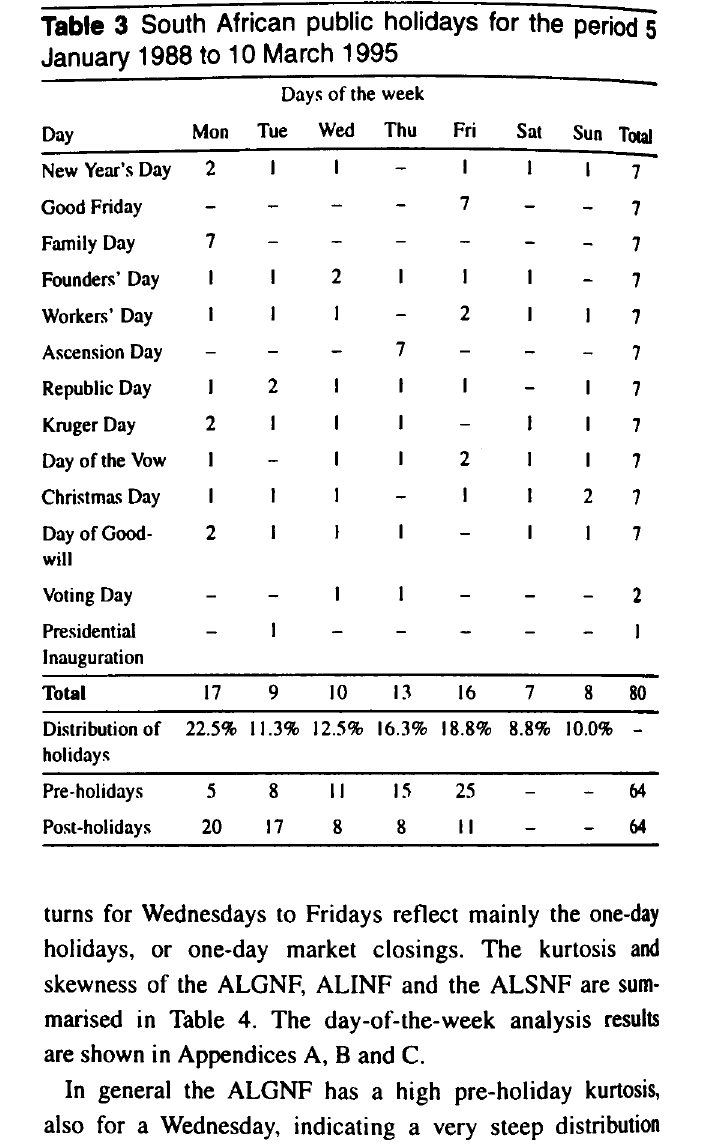
Table 4 Kurtosis and skewness